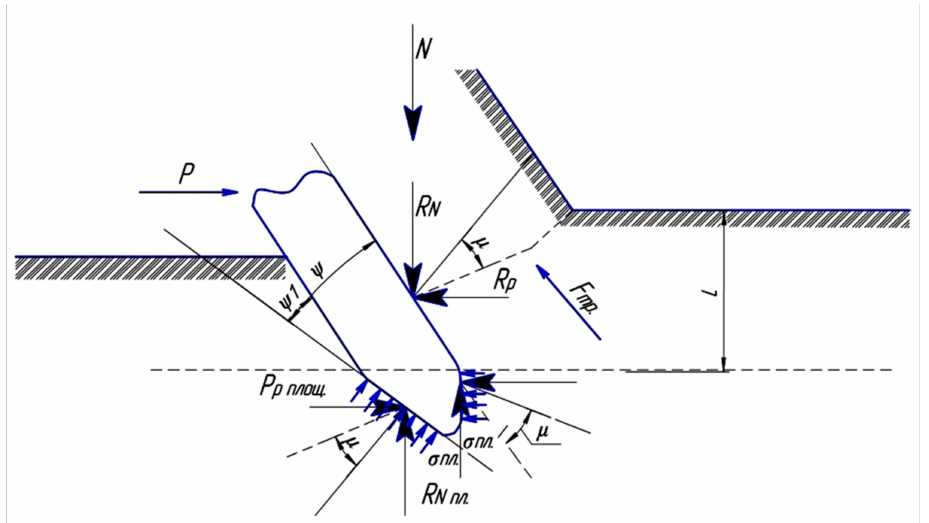
Figure 1. Diagram of forces acting on a worn ripper tooth. ψ , ψ 1 —the angle of penetration of the tooth surface and the angle of deviation of the design surface; F fr —ground friction forces; σ a —the average pressure on the contact area of the tooth wall; R Na —the reaction of forces from the ground to the worn tooth surface; µ —the angle of friction of the worn cutting edge of the tooth; P pf . —pressure on the wear